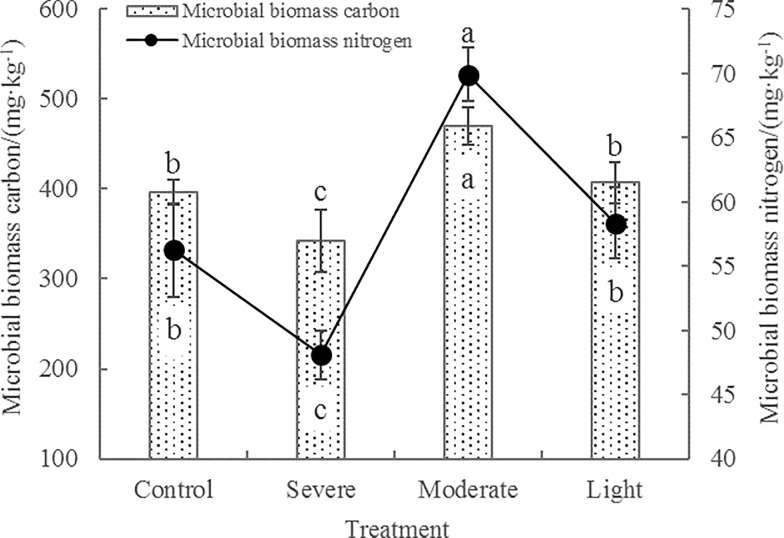
Effects of root pruning on MBC and MBN contents in the rhizosphere soil of poplar.Bars are means, and error bars are standard deviations (n = 3). Different letters indicate significant differences among treatments at P<0.05 by LSD.